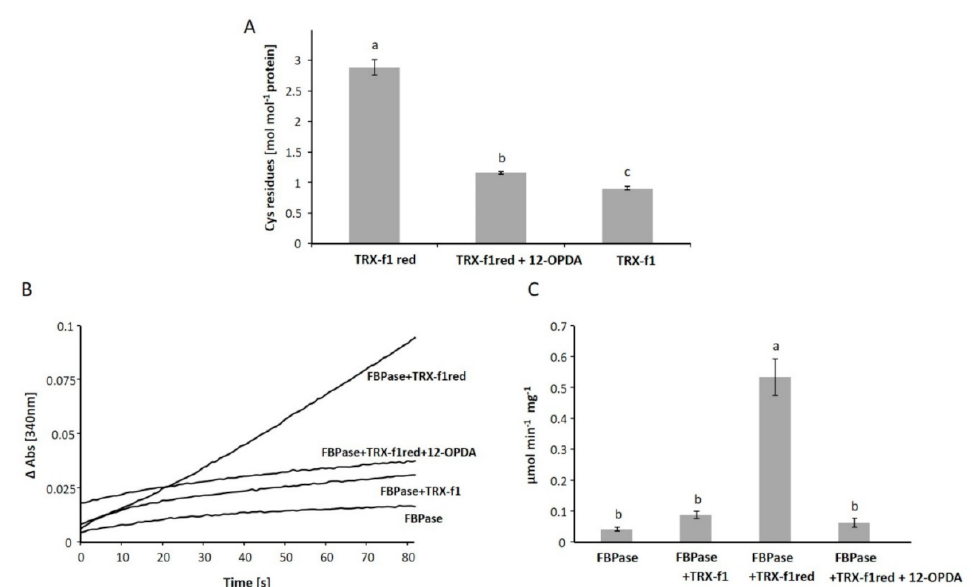
Figure 5. 12-OPDA targets TRX-f1 and affects the activation of fructose 1,6-bisphosphatase (FBPase). ( A ) TRX-f1 thiols were modified by 12-OPDA. The number of thiols in proteins (22 µ M) was detected via the DTNB assay for reduced or untreated TRX-f1 or after incubation of reduced TRX-f1 with 12-OPDA (300 µ M). Data are means of n ≥ 3 ± SD. Significant differences at p ≤ 0.05 were calculated using one-way ANOVA with post hoc Tukey HSD and are represented by letters a–c. ( B ) The activation of FBPase by reduced TRX-f1 was inhibited after incubation with 12-OPDA shown by the FBPase activity test performed with reduced TRX-f1red without 12-OPDA and TRX-f1red with 12-OPDA incubation and untreated TRX-f1 (TRX-f1). The assay was performed 3 times with highly similar results, as seen in the respective calculated mean ± SD of FBPase activities shown in ( C ). Significant differences at p ≤ 0.05 were calculated using one-way ANOVA with post hoc Tukey HSD and are represented by letters